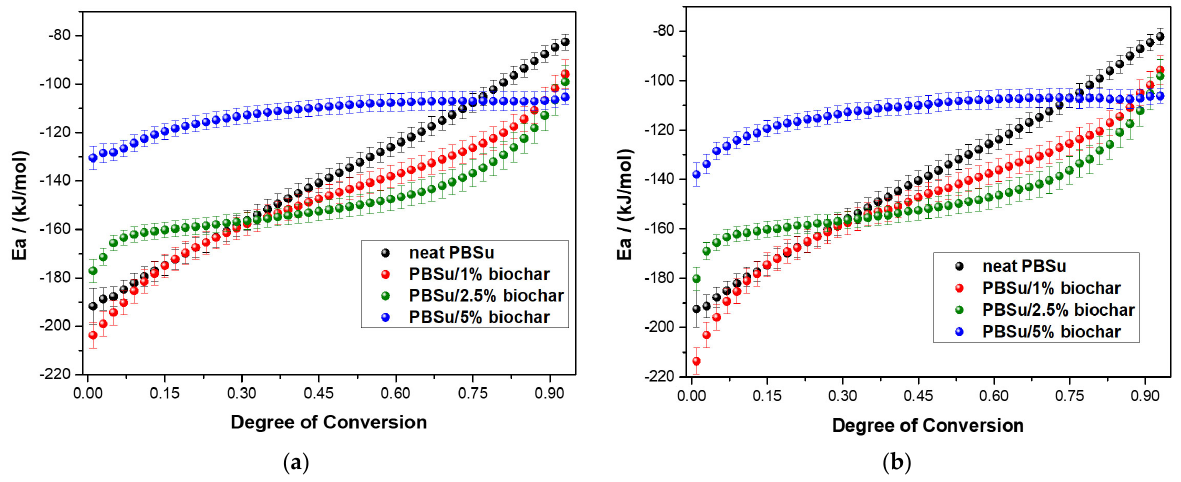
Figure 7. The dependence of activation energy (E α ) on the degree of conversion ( α ) for the non- isothermal crystallization kinetics of neat PBSu and PBSu/biochar composites fi lled by various fi ller content as calculated by ( a ) Friedman method and ( b ) Vyazovkin